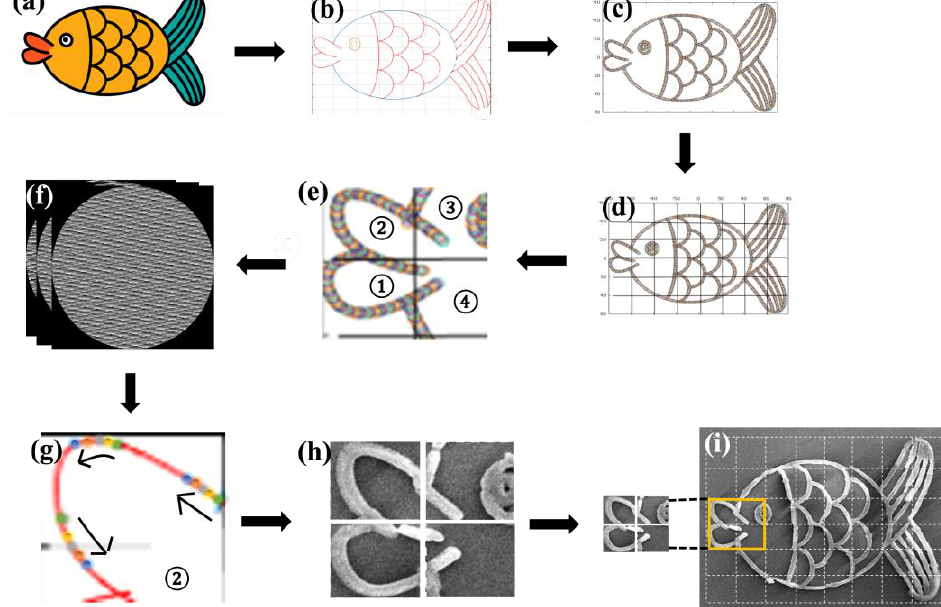
Figure 3. SVG decoding and fabrication flow chart with a carp structure as an example. ( a ) Interpret the SVG into mathematical equations, with a carp pattern as example. ( b ) Construct the outline of the carp. ( c ) Discrete the outline into coordinate points ( 𝑋(𝑙) , Y (𝑙) ). ( d ) Divide the carp structure into different partitions depending on the target size. ( e ) Rearrange the coordinate points ( 𝑋 𝑖 (𝑙) , 𝑌 𝑖 (𝑙) ) in the partitions, e.g. ① , ② , ③ , ④ . ( f ) Generate phase maps with three Bessel – Gaussian laser spots and their movements. ( g ) According to the coordinates through path designing, where the arrows represent the direction of the fabrication path. ( h ) Local fabrication result, and ( i ) The overall fabrication result.